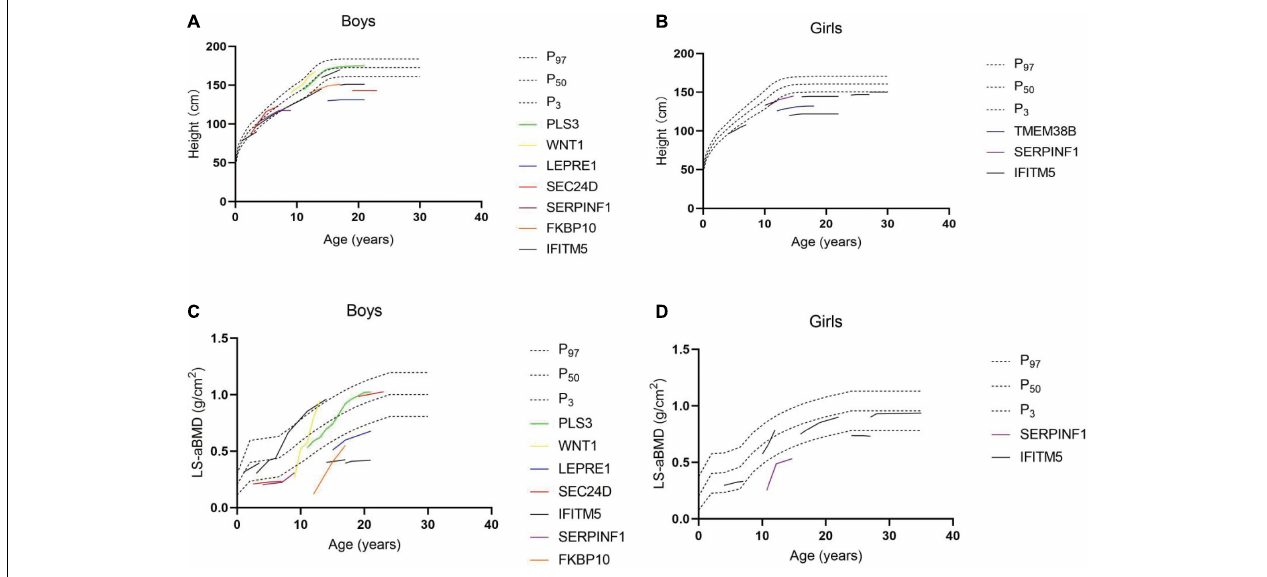
FIGURE 2 | Follow-up results of height in male (A) and female (B) patients. Follow-up results of bone mineral density of lumbar spine in male (C) and female (D)